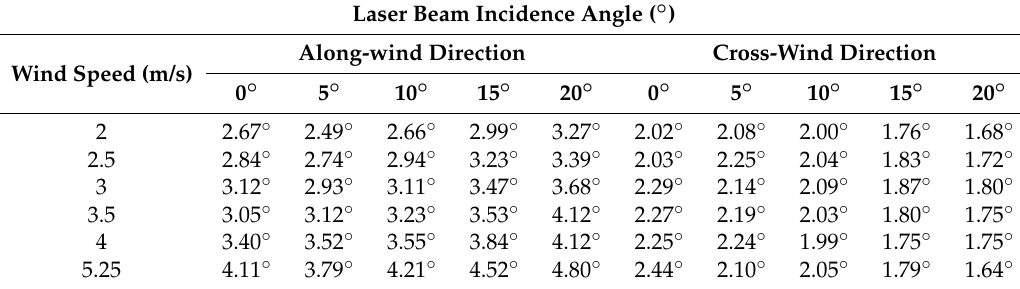
Table 3. Refraction angle standard deviations (2 σ ) in the along-wind and cross-wind directions as obtained from Monte Carlo simulations for laser beam diameter of 0.25 m.